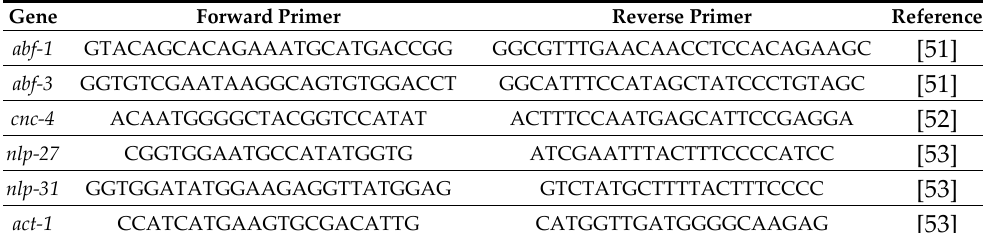
Table 2. Primers sequence of C. elegans antimicrobial